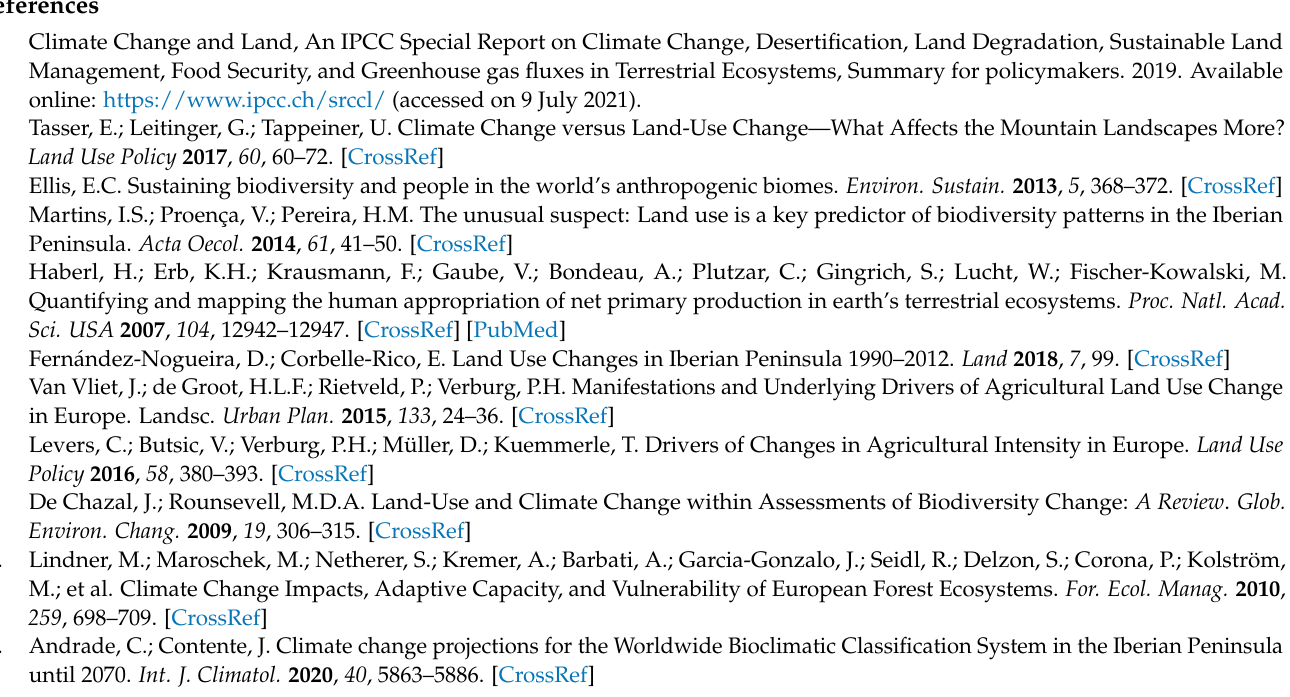
Figure S3: Evolution of the total olive grove areas (in ha) for mainland Portugal between 1990 and 2018; Figure S4: Evolution of the total olive production (in ton) for mainland Portugal between 2000 and